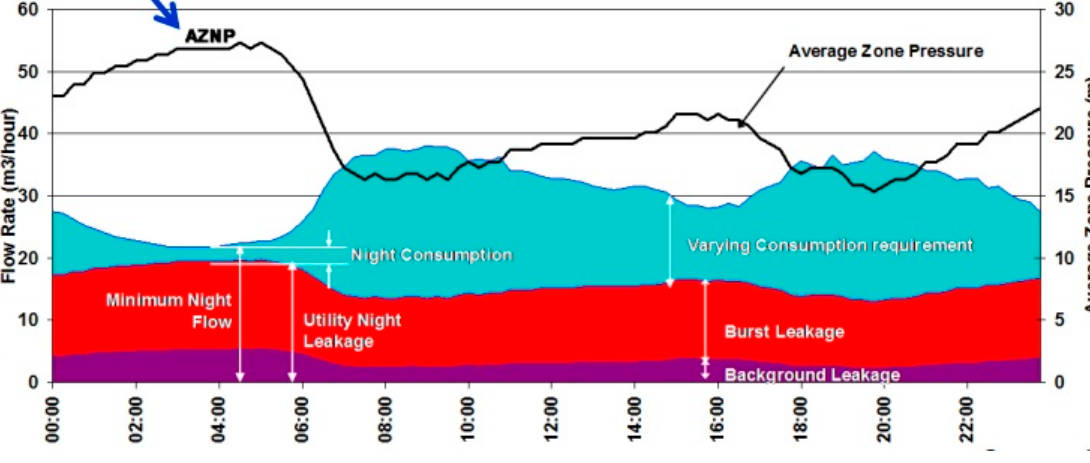
Figure 9. Variation of Utility Leakage Components with AZP, source: R.Liemberger